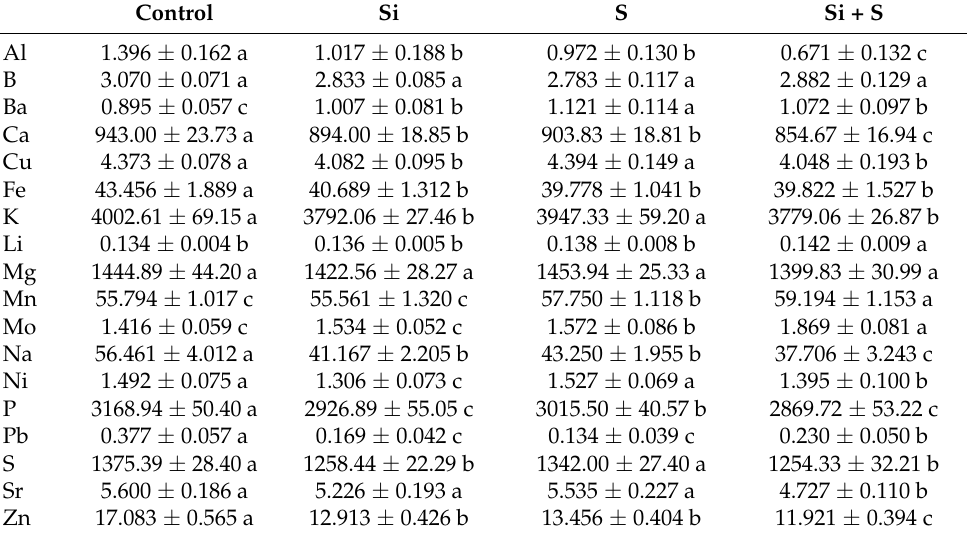
Different letters mean statistically different values in the rows, at p =